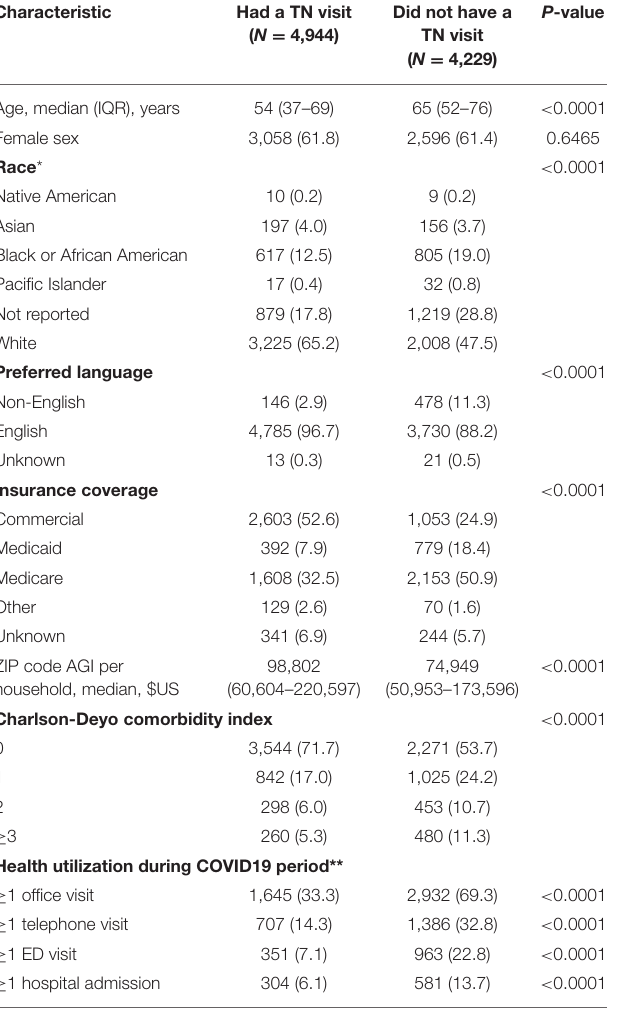
TABLE 3 | Multivariable analysis of characteristics associated with TN utilization during the COVID period.